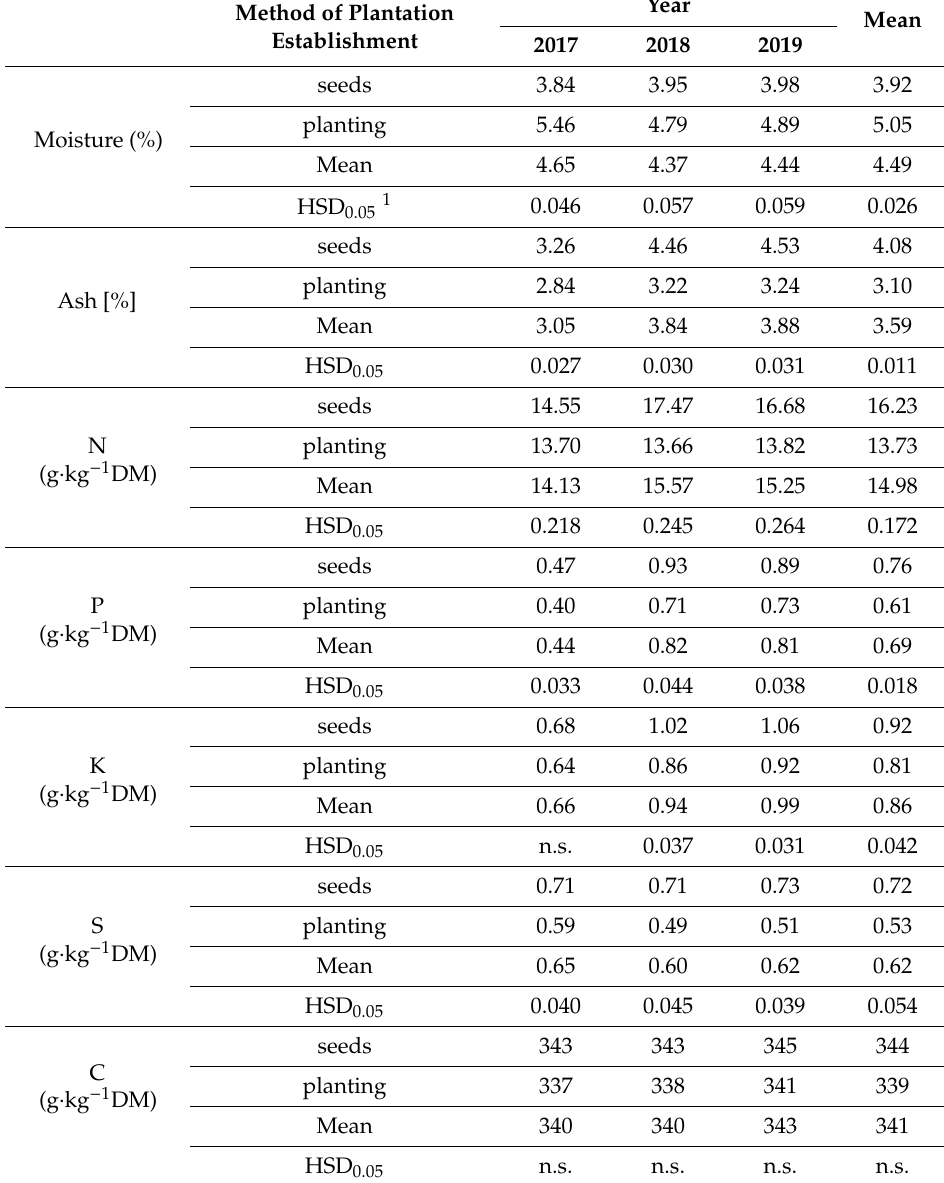
Table 12. The content of analytic moisture and ash (%) and the total content of nitrogen, phosphorus, potassium, sulfur and carbon (g · kg − 1 DM) in the biomass of Silphium , depending on methods of plantation